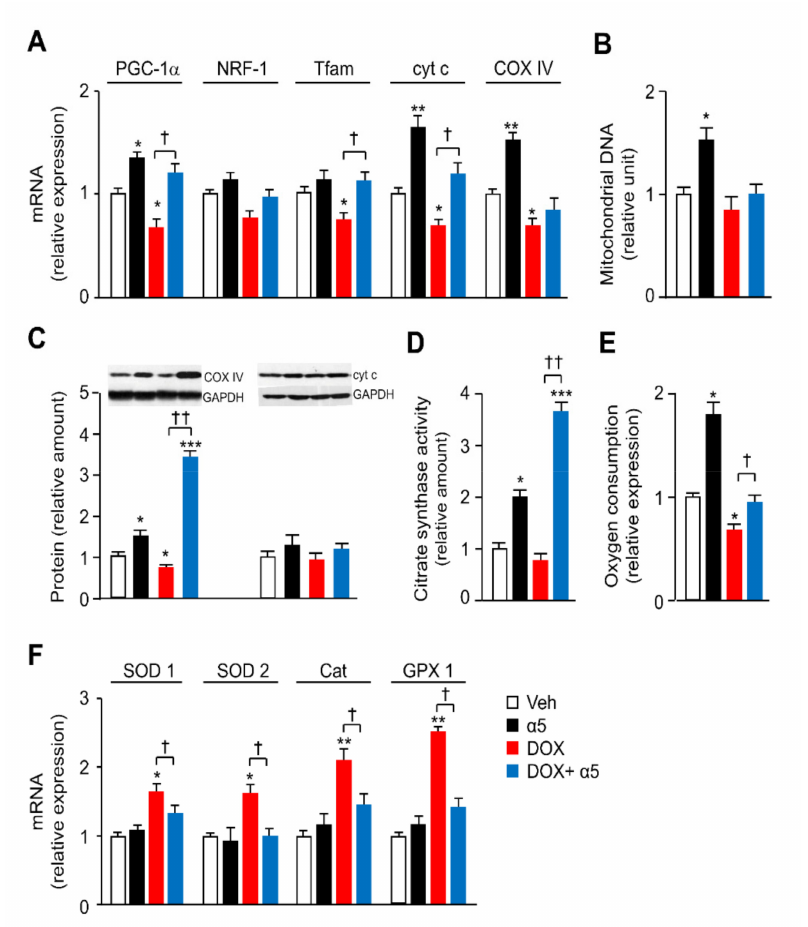
Figure 5. α 5 formula prevents mitochondrial dysfunction in left ventricle of DOX-treated